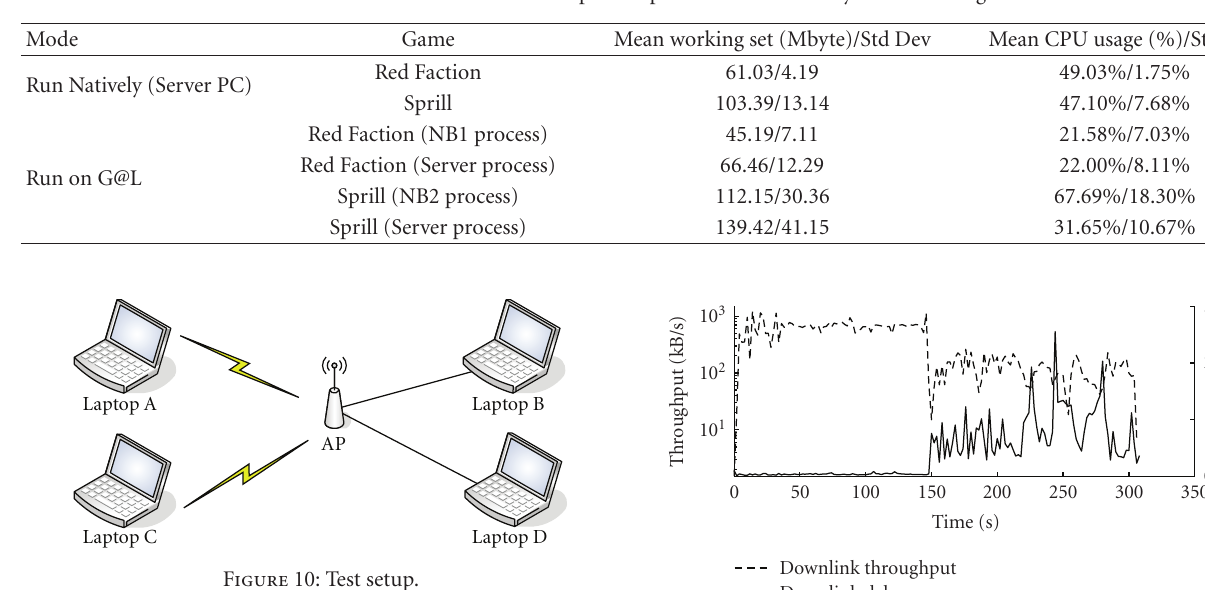
Table 2: G@L Server and Client process performance: Memory and CPU usage.